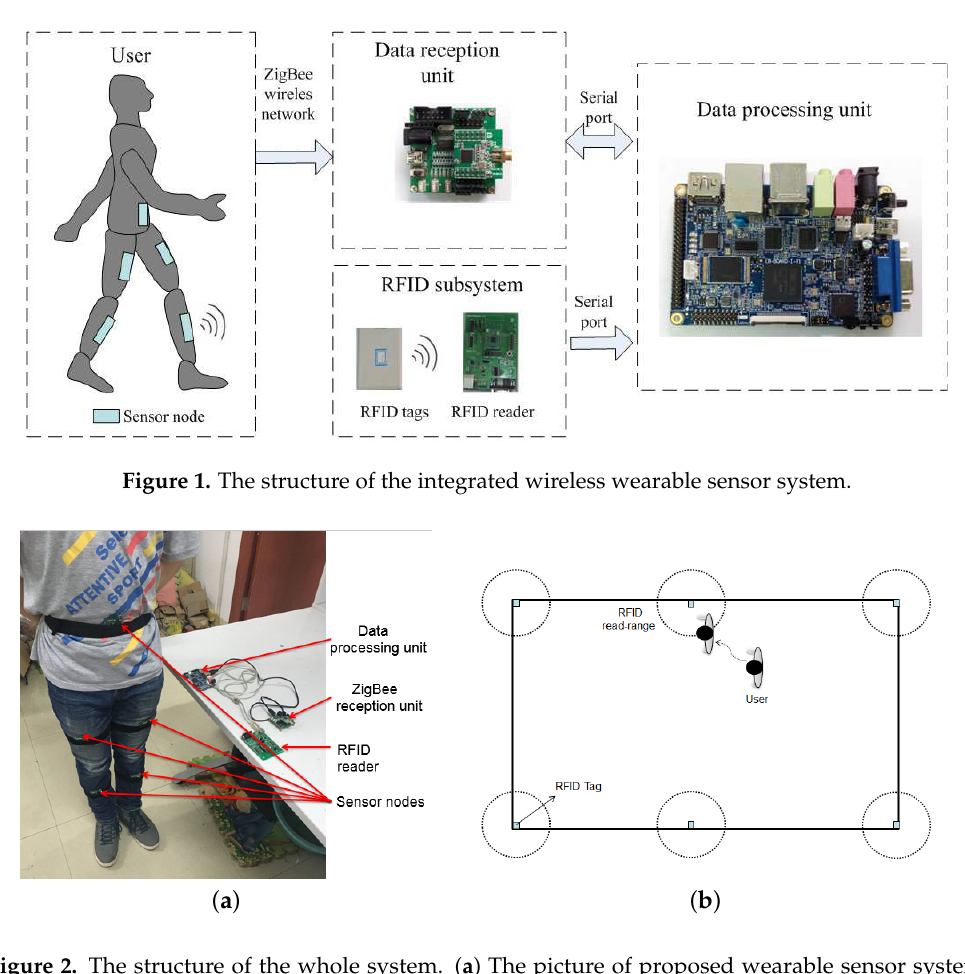
Figure 2. The structure of the whole system. ( a ) The picture of proposed wearable sensor system; ( b ) Work principle of indoor localization corrected by Radio Frequency Identification (RFID)